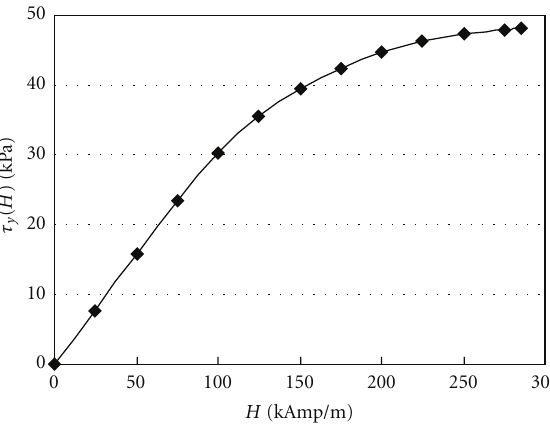
Figure 5: Yield stress versus magnetic field strength.